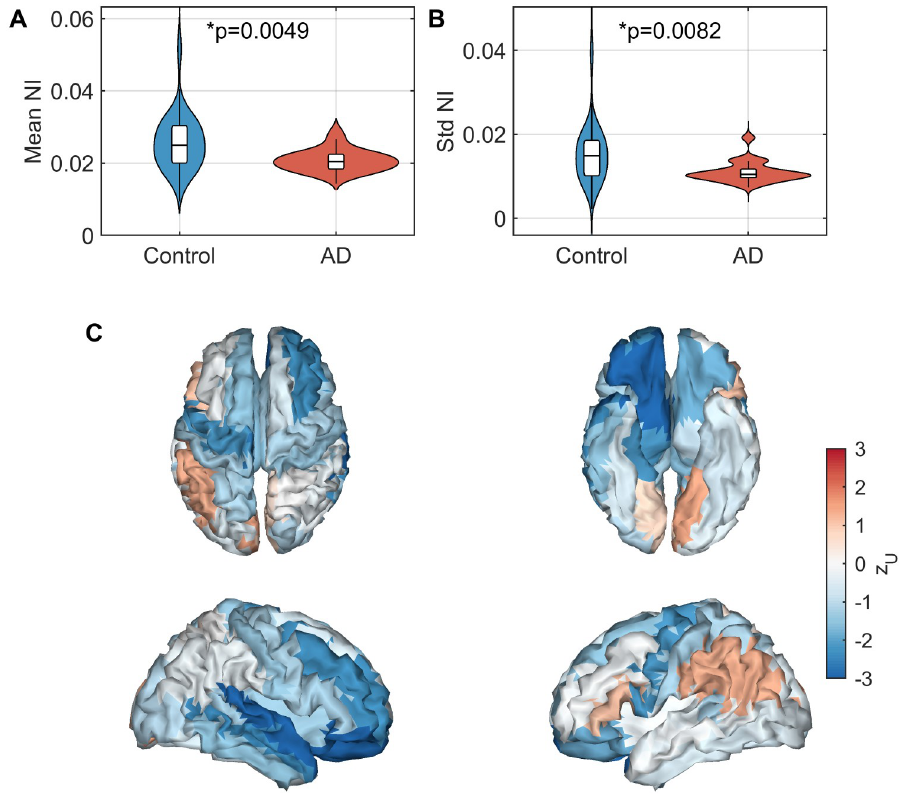
Fig 4. Analysis of NI scores in AD relative to controls. (A) Mean NI across nodes. (B) Standard deviation of NI across nodes. (C) Effect sizes of differences in NI between AD and controls for each ROI, quantified by the z -score of the U -statistic. Parameters are those given in Fig